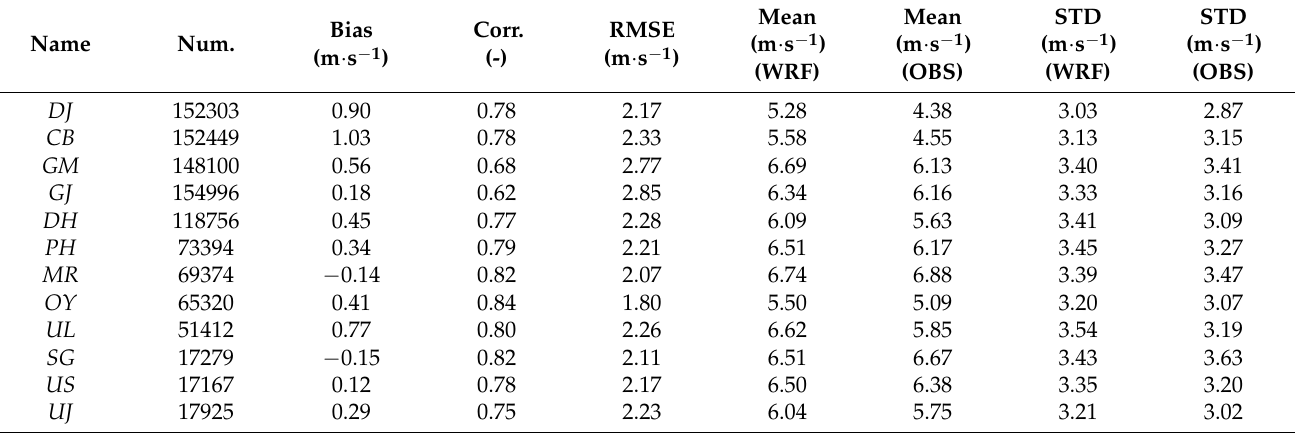
points, the WRF hindcast showed consistency. Table 4. Error metrics for the wind speed derived from buoy observation stations (OBS) and the Weather Research and Forecasting (WRF) model hindcast. Name